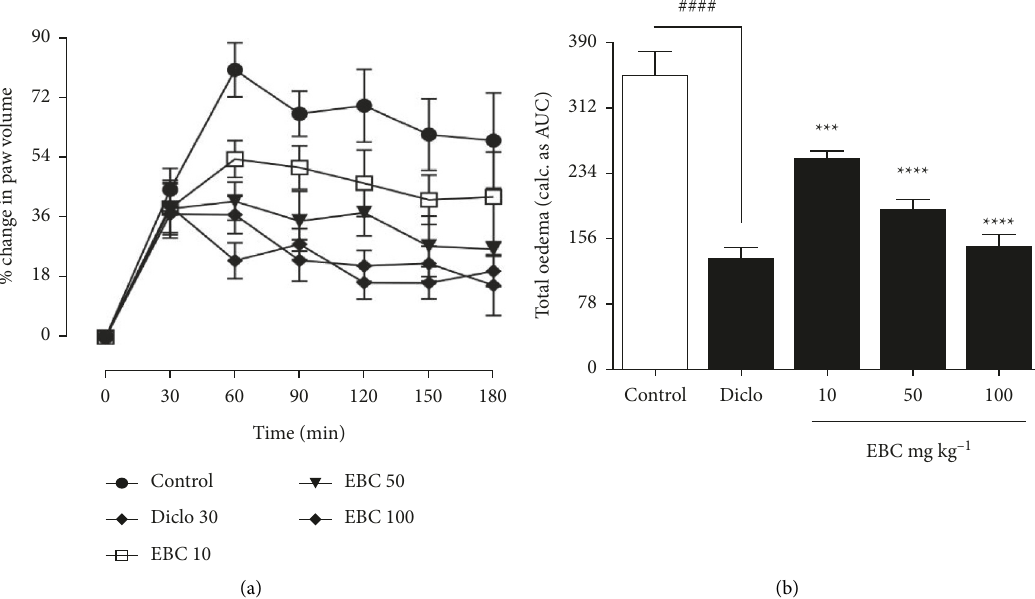
Figure 1: Bombax costatum extract inhibits prostaglandin E 200 µ L 1 n M PGE 2 into the subplantar tissue of the right hind paw (a) Total oedema induced during the 3h period was calculated as area under the time-course curves, AUC (b) Data are presented as Mean